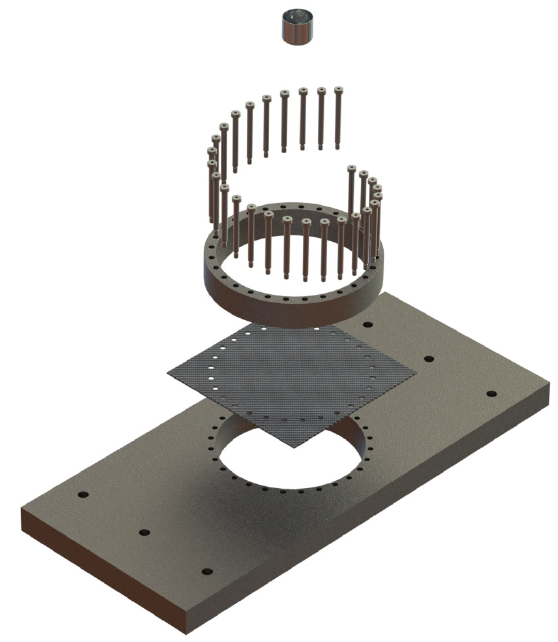
Figure 1. ASTM D8101 standard: Measuring the Penetration Resistance of Composite Materials to Impact by a Blunt Projectile. Impact by a Blunt